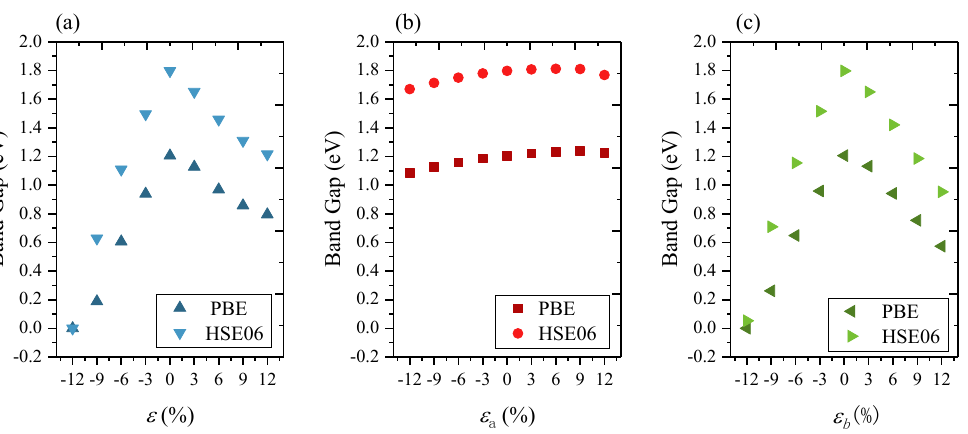
Figure 7. The changes in band gap when different strains were applied: ( a ) under the biaxial strain, ( b ) under the uniaxial strain along the a -direction, and ( c ) under uniaxial strain along the b -direction using the PBE and HSE06 methods.